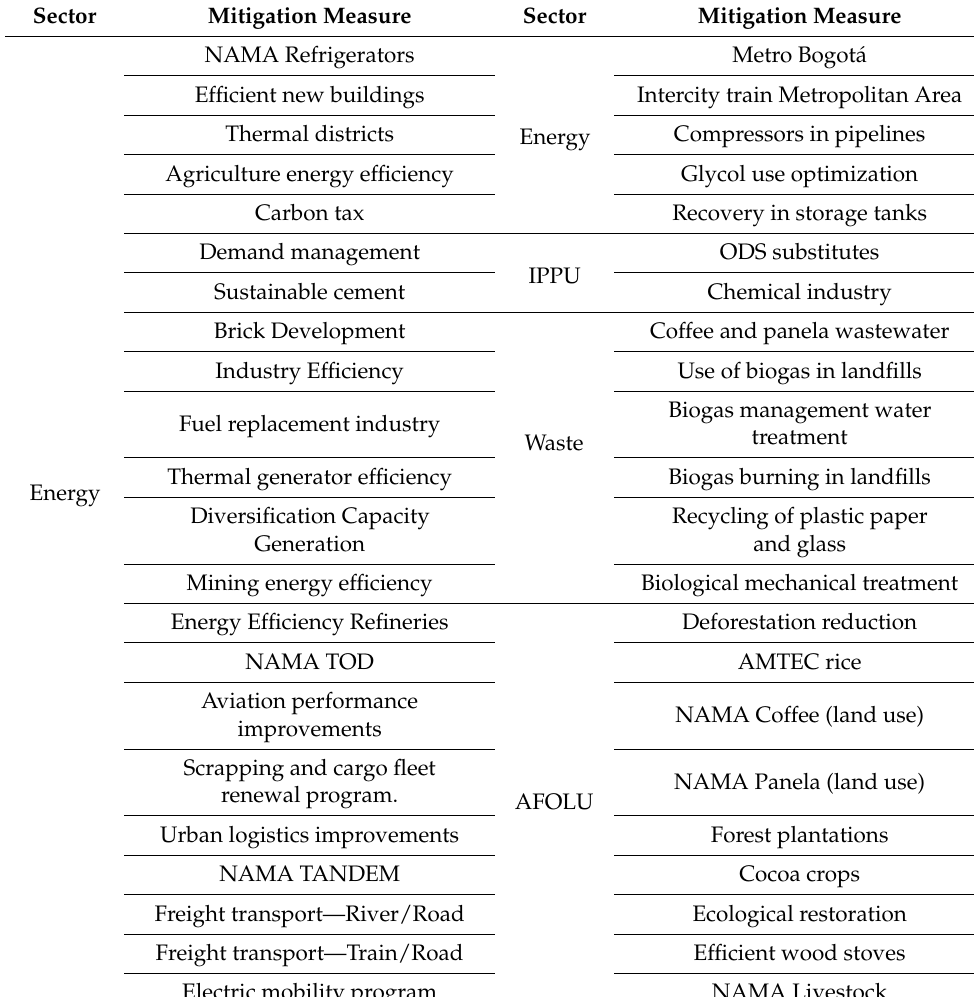
Table 11. Mitigation portfolio included in the mitigation